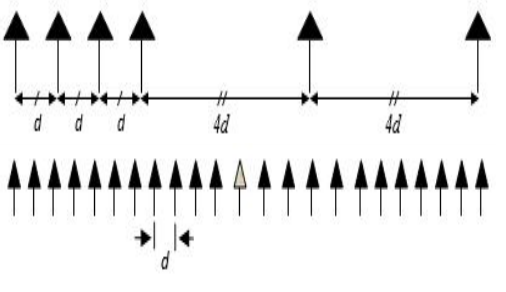
Figure 4. The proposed sparse ( upper ) and the virtual co-array ( lower